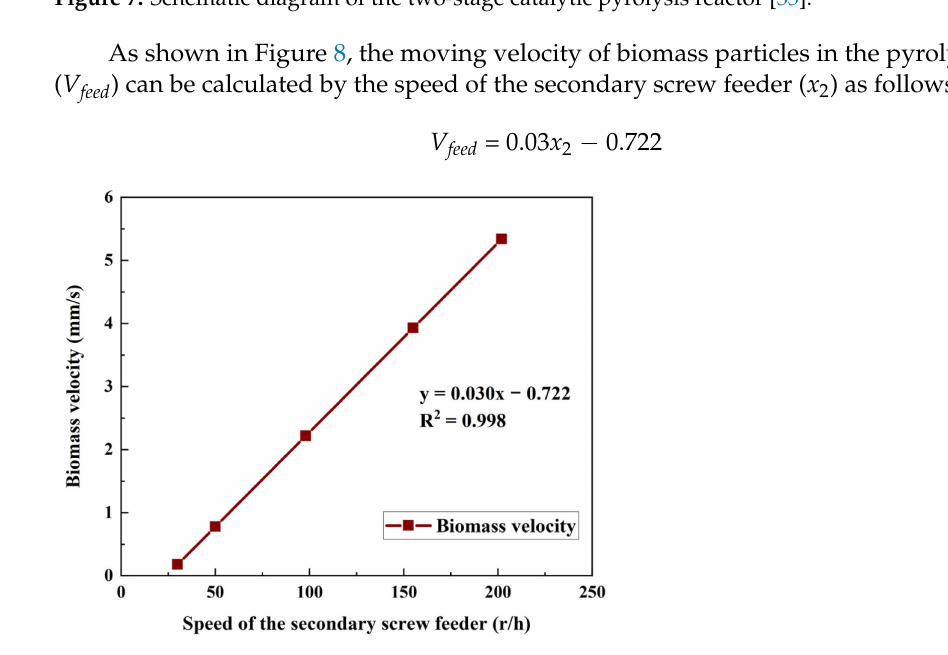
Figure 7. Schematic diagram of the two-stage catalytic pyrolysis reactor [35].